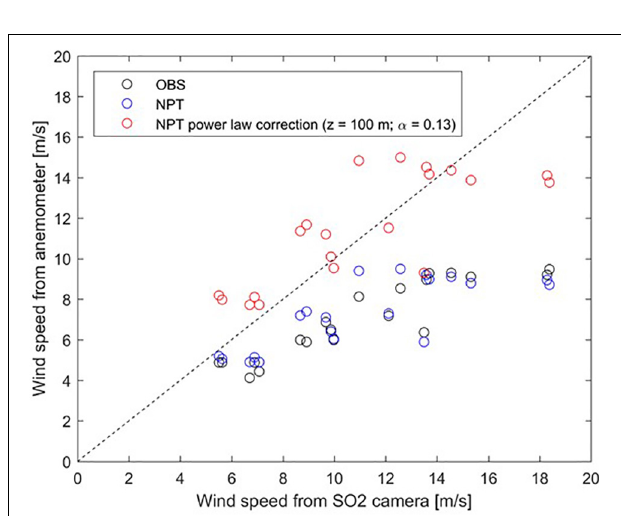
FIGURE 10 | Comparison of wind speeds derived from the SO 2 camera (horizontal axis) with wind speeds from anemometers at HVO and NPT. Data are from March 24, 2014, April 21, 2014, and March 30, 2017. Anemometer data is interpolated to timing of SO 2 camera measurements. The wind speed calculated with SO 2 camera data plot systematically higher than the anemometer data, with differences increasing for larger wind speeds. Applying a power law correction to the NPT data (red circles) brings them into the same range as the camera wind